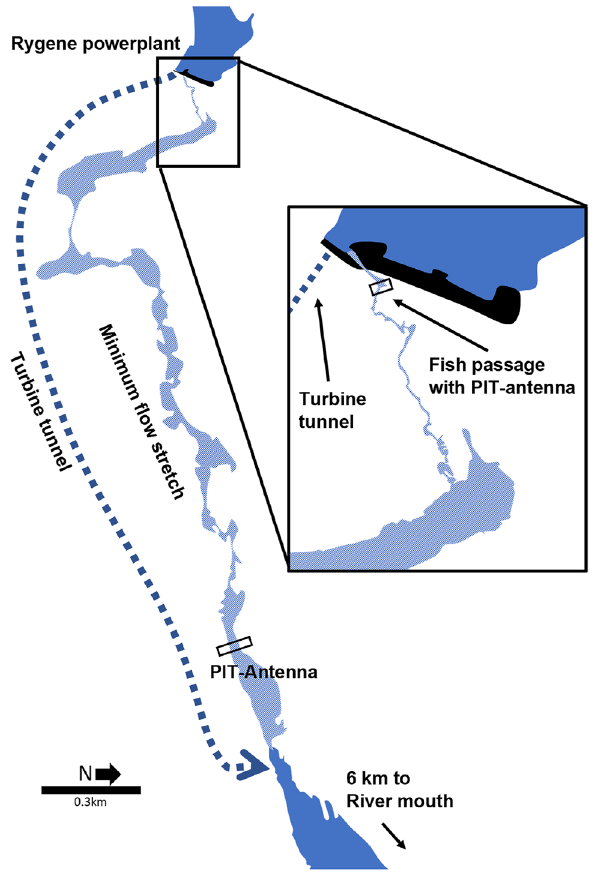
Figure 1. River Nidelva with Rygene hydropower dam with water intake and fish passage including the downstream minimum flow stretch with the parallel turbine water tunnel that exits into River Nidelva 6 km upstream of the river mouth. PIT-antennas in both ends of the minimum flow stretch detect returning PIT- tagged Atlantic salmon